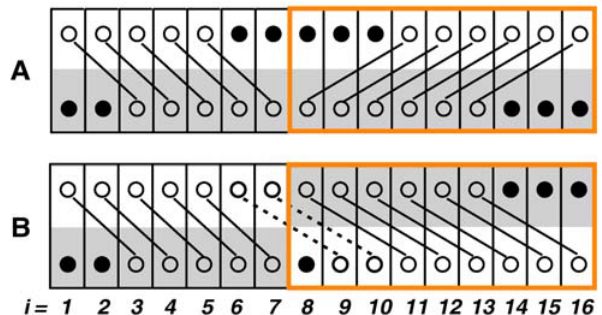
Figure 6. Two aligned solutions of the same mixed fragment, representing the transition between the phase shifts k i =2 and k i =3, alternatively, as a ‘‘long’’ insertion (A) or a ‘‘short’’ insertion (B). Bases corresponding to the lower allelic string in (A) are highlighted with grey. Note that one solution can be obtained from another by swapping the parts of the allelic strings between sites 8 and 16 (orange box).